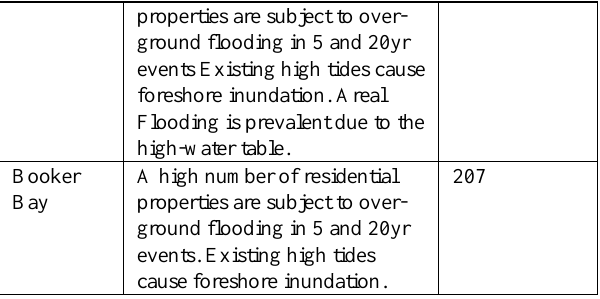
Table 1: Brisbane Water Communities background